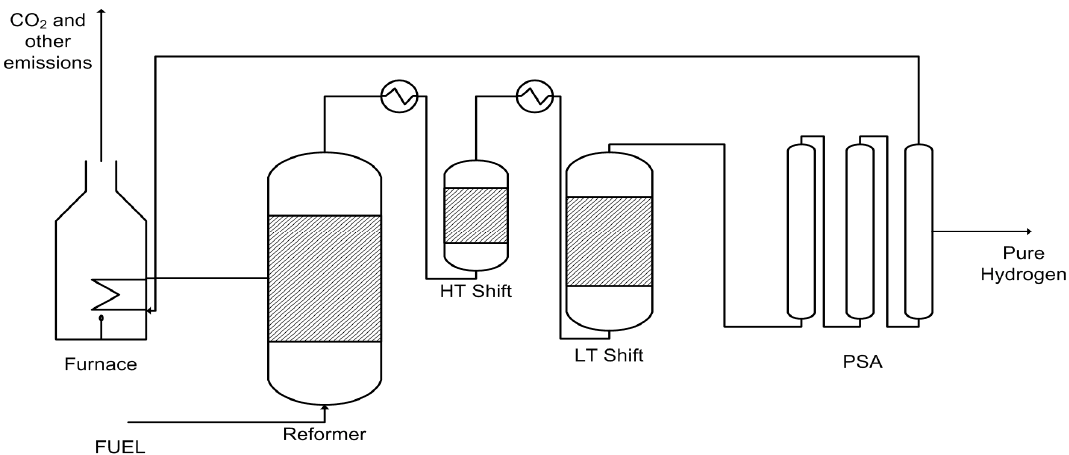
Figure 5. Schematic of conventional steam methane reforming process for hydrogen production.